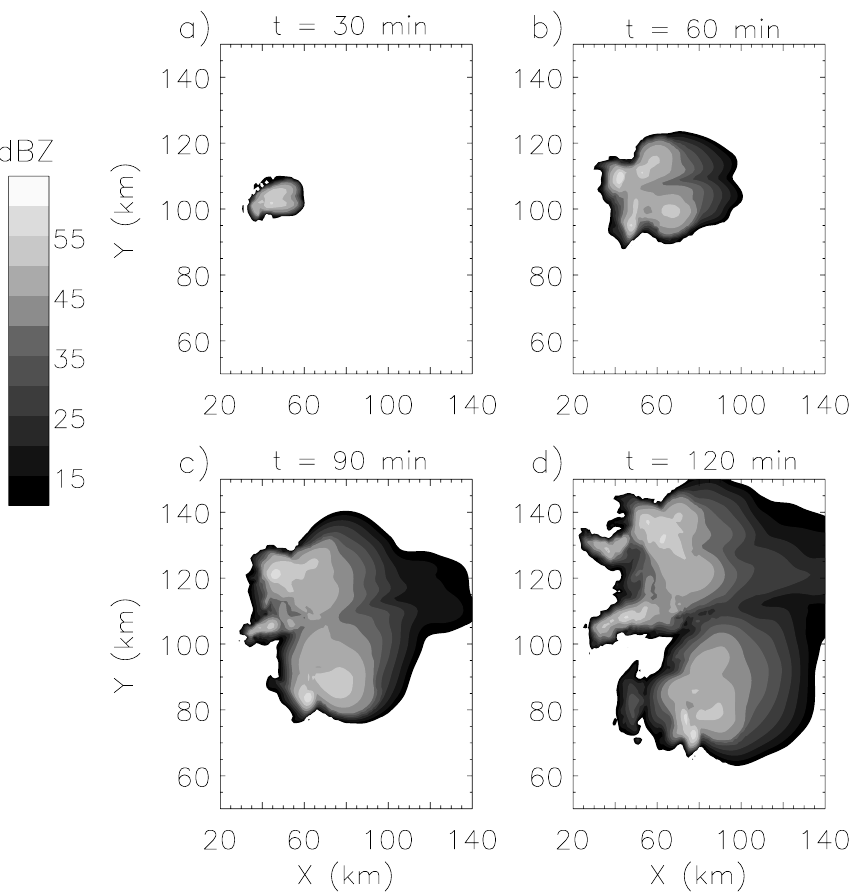
Fig. 7. Horizontal plots of lowest model level ( ∼ 250m) radar reflectivity at t = (a) 30, (b) 60, (c) , 90, and (d) 120min for the BASE configuration and pristine (PRIS)